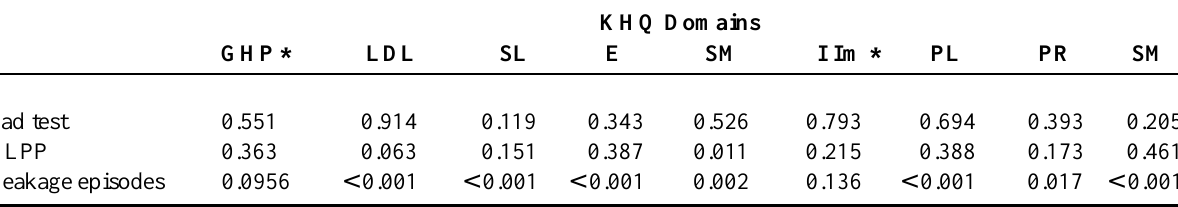
Table 7 – Influence of the objective variables on KHQ domains (p